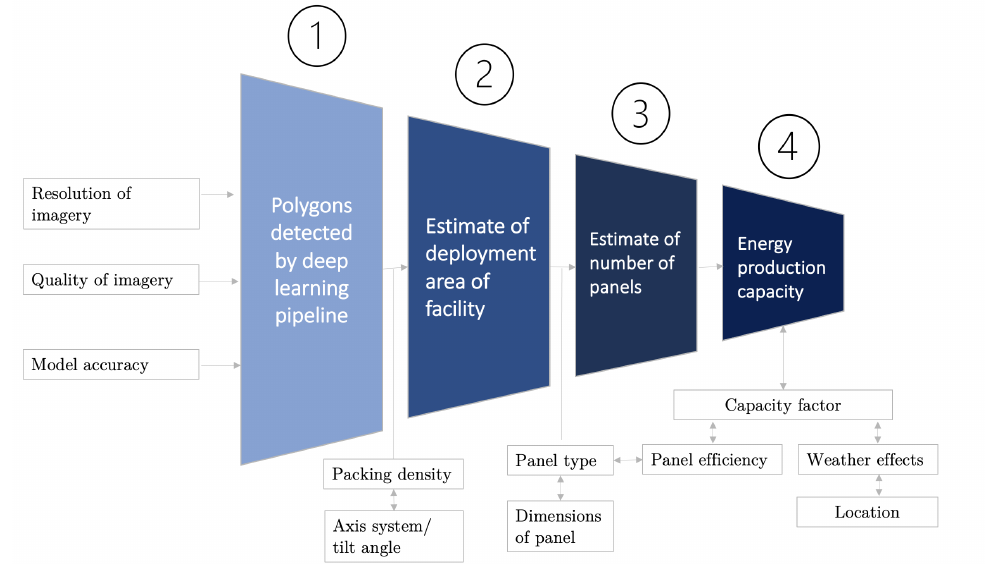
Figure 6. Depiction of the capacity evaluation model for solar farms. The goal is to estimate annual energy generation from polygons detected by the deep learning model on remotely sensed